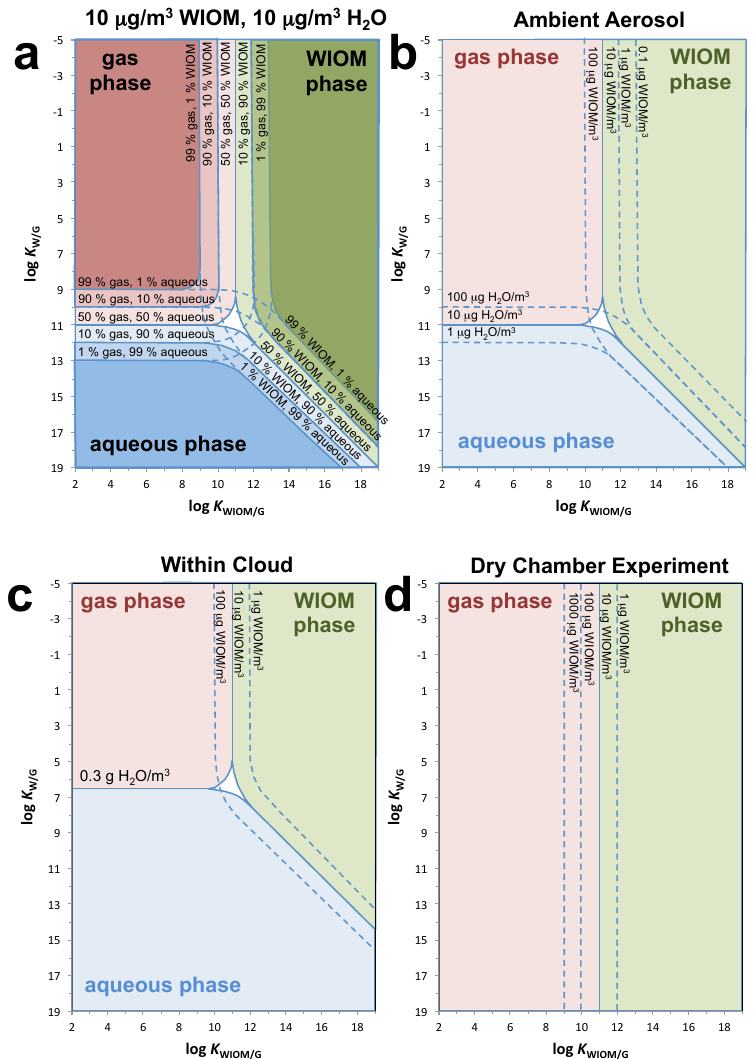
Figure 1. Different versions of the chemical partitioning space for the atmosphere, showing in red, blue and green the combinations of partitioning properties that lead to dominant equilibrium partitioning to the gas, aqueous and water-insoluble organic matter (WIOM) phase, respectively. Panel (a) refers to typical atmospheric conditions of 10µg of both WIOM and liquid water per m 3 of air and demonstrates that the transition from 1 (10) to 99 (90)% in a particular phase occurs over a 4 (2) order of magnitude range in a partition coefficient. A clear atmosphere ( a and b ), a cloud (c) and a dry chamber experiment (d) only differ in terms of the relative volume of the three phases present, leading to shifts in the thresholds indicating 50% partitioning into any one phase. Dashed lines in (b) – (d) indicate the 50% threshold for various loadings of WIOM and various liquid water